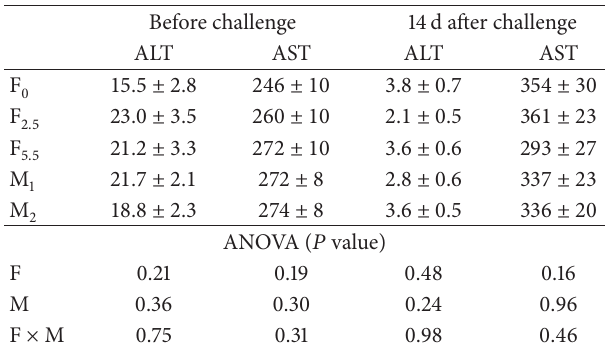
Table6:Effectoffishoilandmethioninesupplementationonserum cholesterol and triglyceride levels (mmol/L) in broiler chickens challenged with